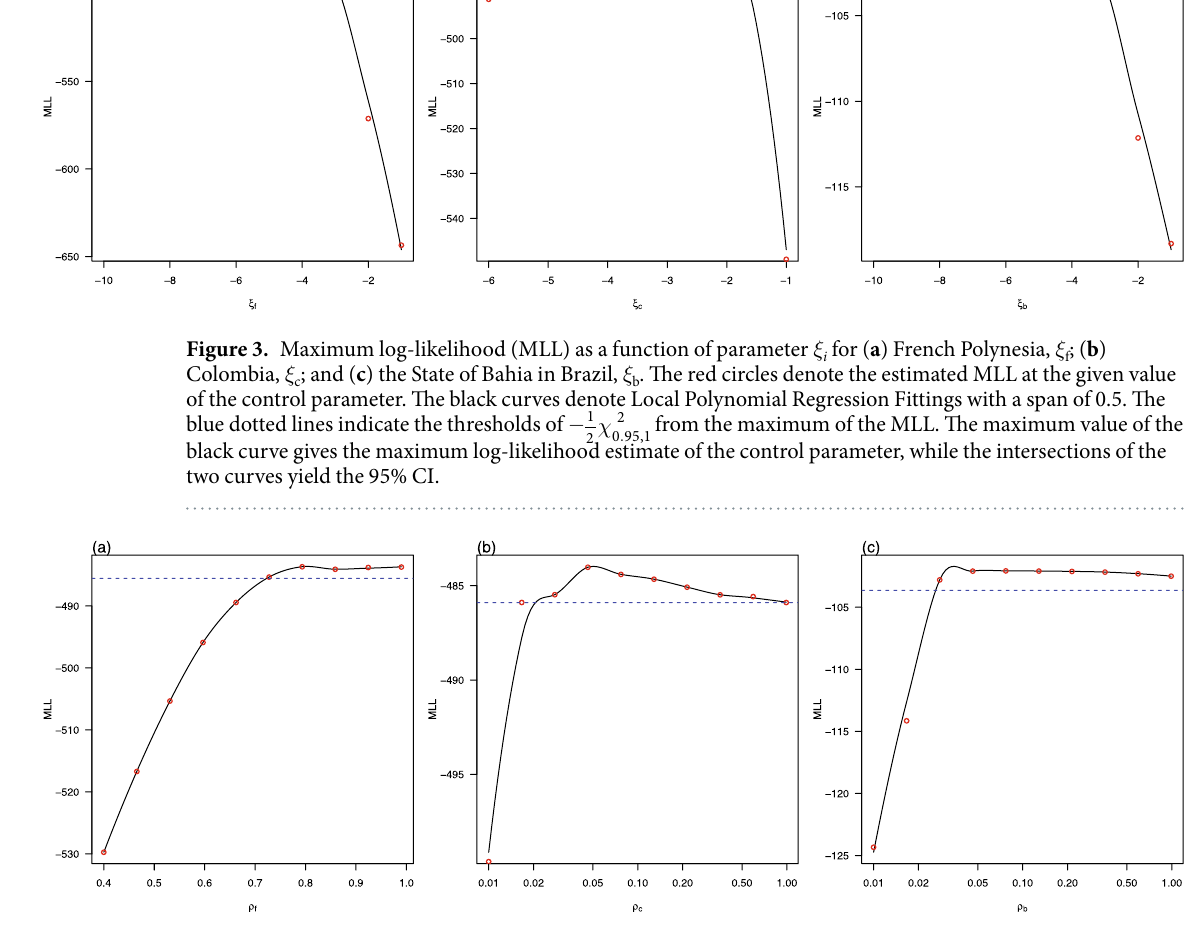
1 95,12 from the maximum of the MLL. The . 2 0